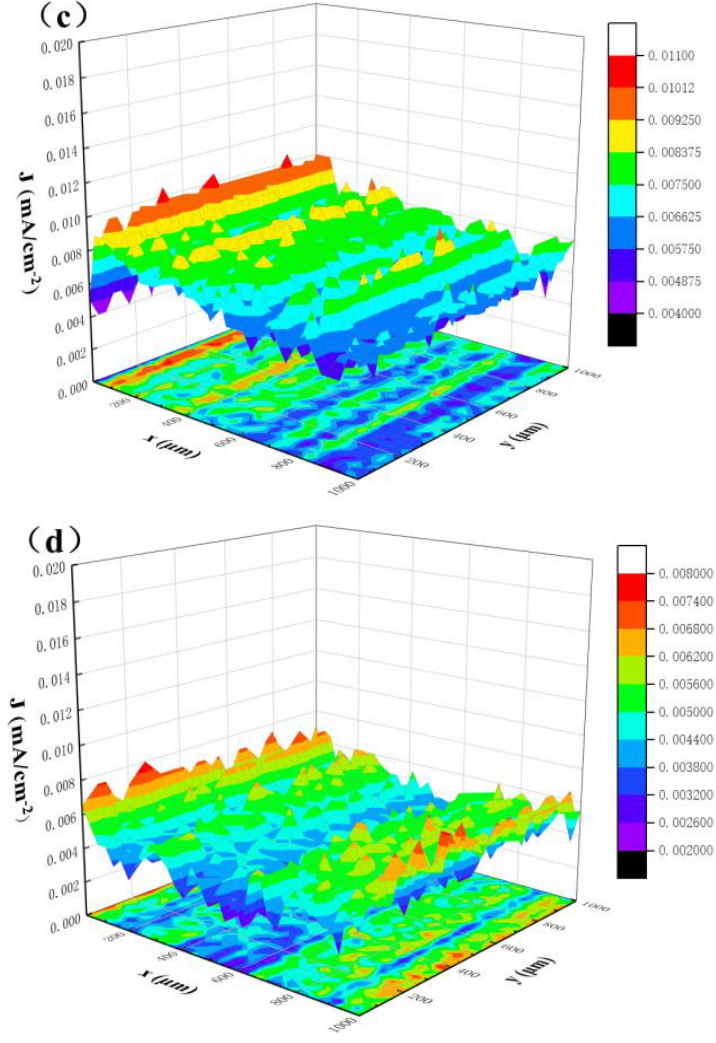
Figure 8. SVET images of copper soaked in formic acid and acetic acid solutions for different times: ( a ) Formic acid, 480 h; ( b ) Acetic acid, 480 h; ( c ) Formic acid; 960 h, ( d ) Acetic acid, 960 h.